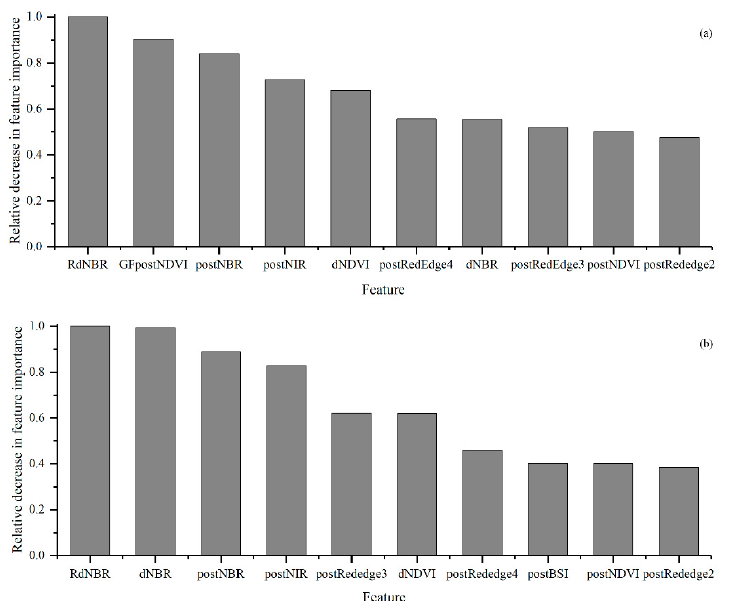
Figure 5. Ranked feature importance of each variable in the S2-GF model ( a ) and the S2 model ( b ), with 1 representing the most important feature. The figure only shows the top ten variables. Only GFpostNDVI, which means the NDVI of the post-fire GF image, was derived from GF images. The other features were obtained from Sentinel 2 images.